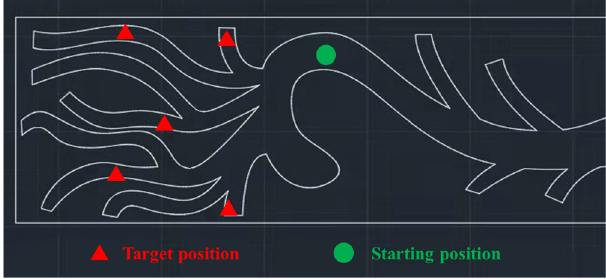
Figure 2. The five vascular interventional tasks for assessing surgeons’ guidewire manipulation skills.